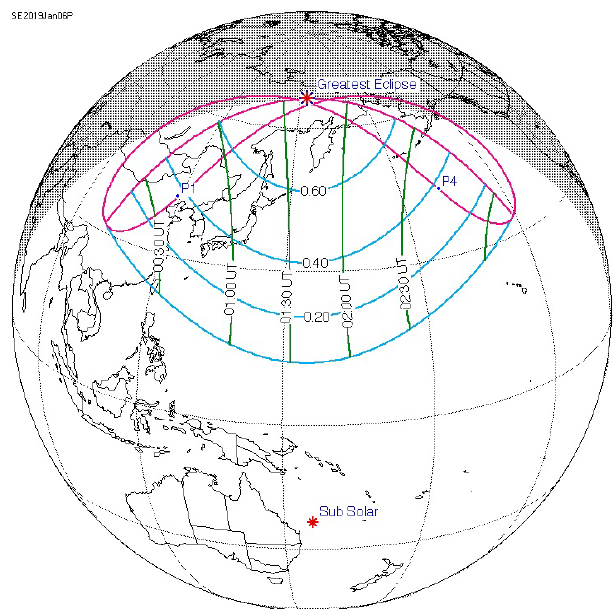
Figure 3. Schematic display of the Moon’s shadow during the course of the partial solar eclipse of 5–6 January 2019. Retrieved from https://eclipse.gsfc.nasa.gov/JSEX/JSEX-AS.html, last ac- cess: 20 September